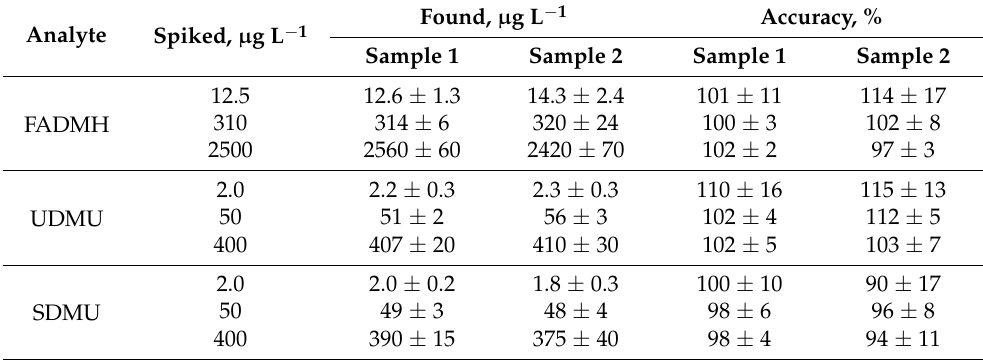
Table 4. Accuracy of the method determined by spike recovery test on real samples of river and beat bog water (n = 3, p = 0.95). Found, µ g L − Analyte Spiked, µ g L − 1